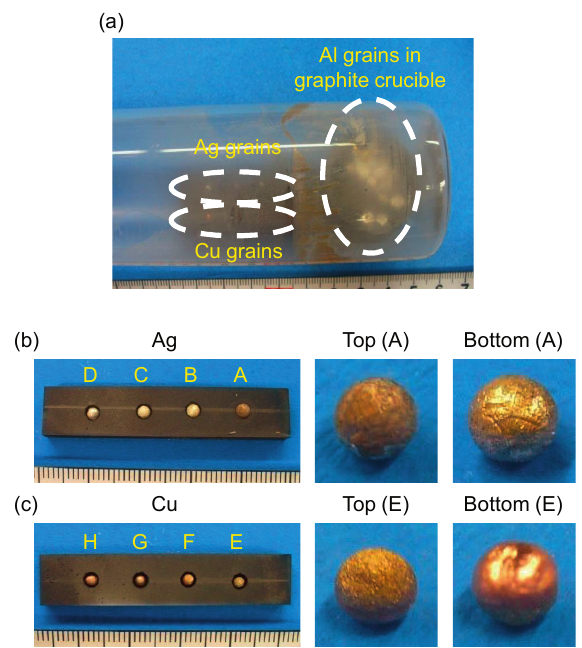
Figure 7. Photographs of (a) the experimental setup before the reaction, and of (b) Ag and (c) Cu grains after the reac- tion in Exp.